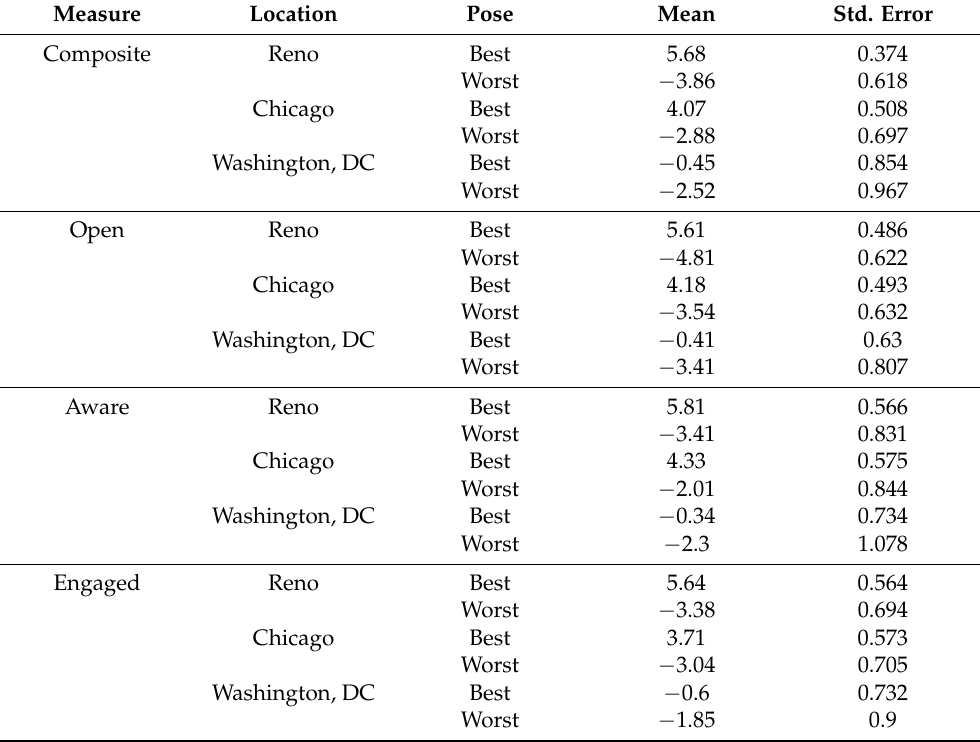
Table 1. Mean scores by measure, pose, and location. Measure Location Pose Mean Std.